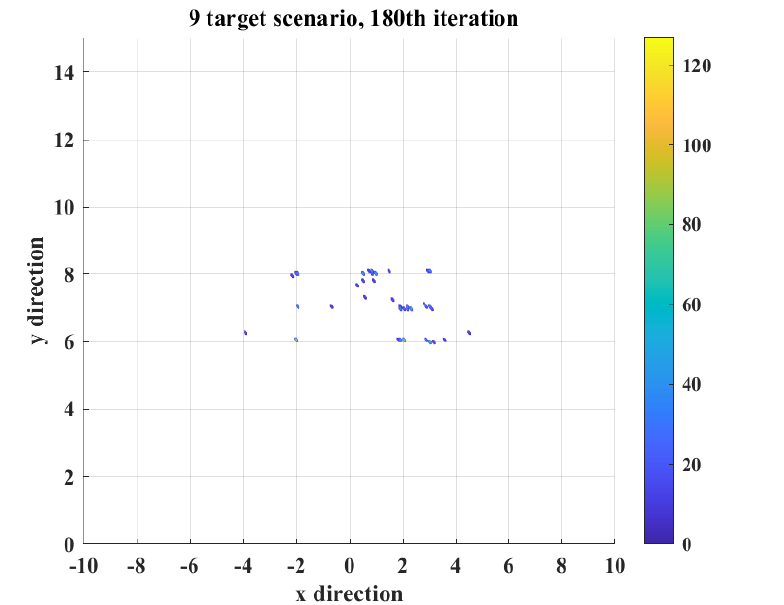
Figure 15. Surviving particles of the proposed algorithm at the end of 180 th iteration for the same scenario as in Figure 13. The color scale indicates the mass of the